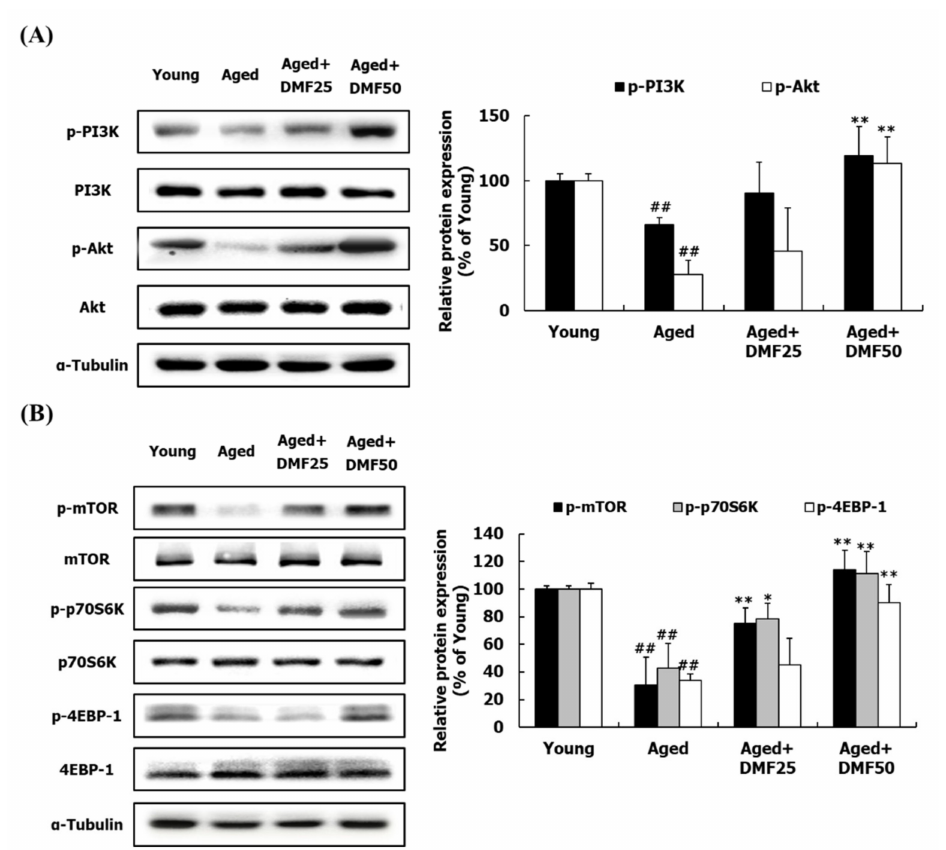
Figure 4. E ff ects of DMF on PI3K-Akt and mTOR pathways in the gastrocnemius muscle. ( A ) Relative phosphorylation of PI3K and Akt. ( B ) Relative phosphorylation of mTOR, p70S6K, and 4EBP1. Results are presented as mean ± SD; ## p < 0.01 vs. Young group; * p < 0.05, ** p < 0.01 vs. Aged